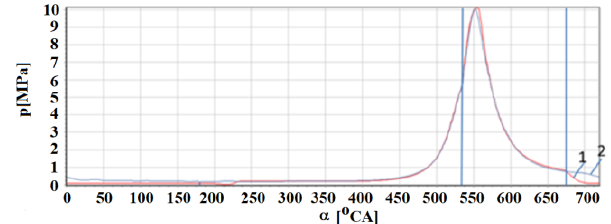
Fig. 5. Curves of the medium pressure: 1 – obtained from the model, 2 – measured as the function of the crankshaft revolution angle